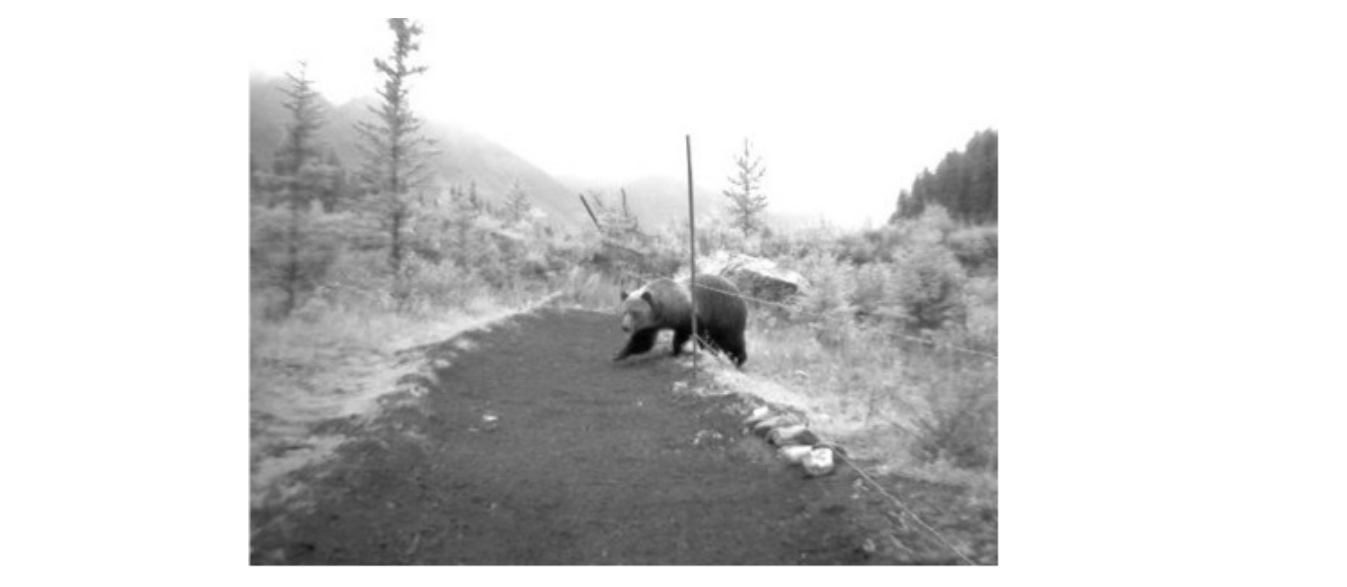
Fig. 3. Grizzly bear passing through hair-sampling system at one of the wildlife overpasses in Banff National